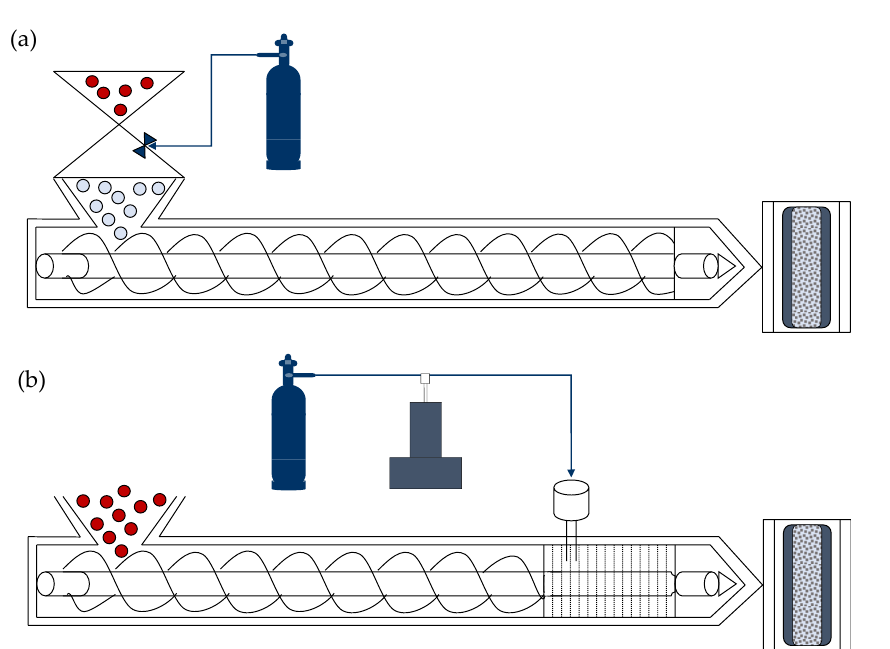
Figure 1. MIM technologies. ( a ) Volkswagen’s Ku-Fizz process with gas supply and a pressurized, modified hopper unit and ( b ) Trexel’s MuCell technology with gas supply, modified screw, SCF metering and control system and a SCF interface kit.